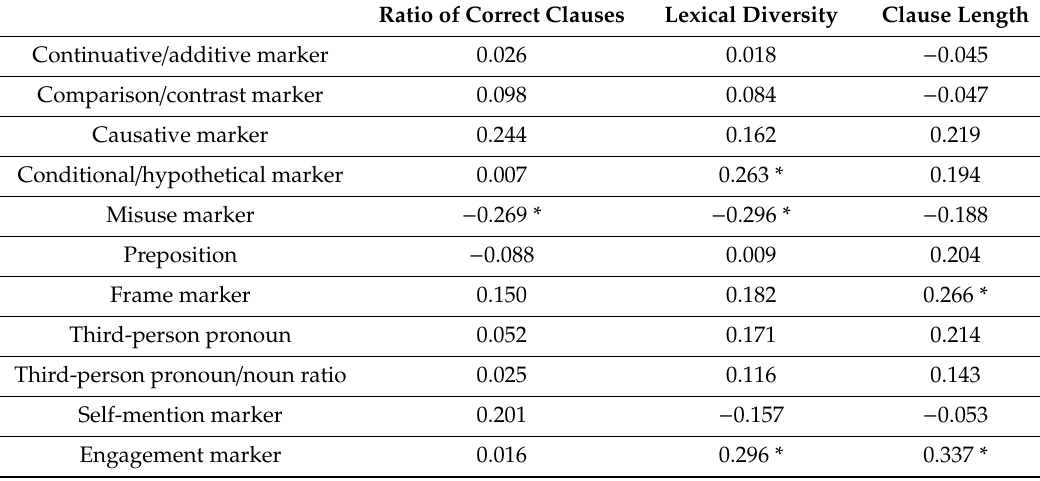
Table 7. Correlations between organizational measures and linguistic measures ( n =